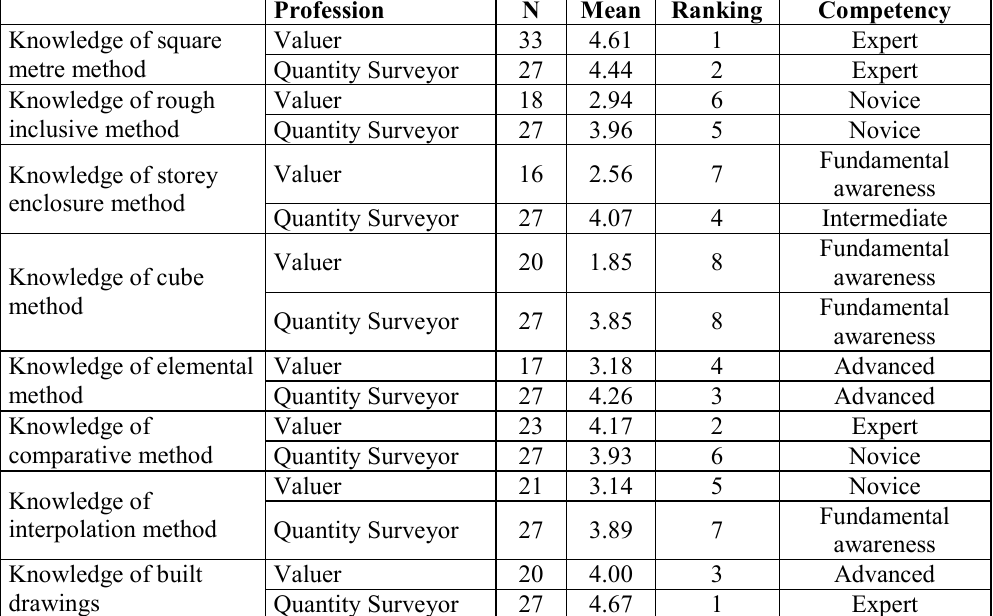
Table 2. Competency Level Rankings of Cost Estimating Methods between Valuers & Quantity Surveyors (developed by the authors)